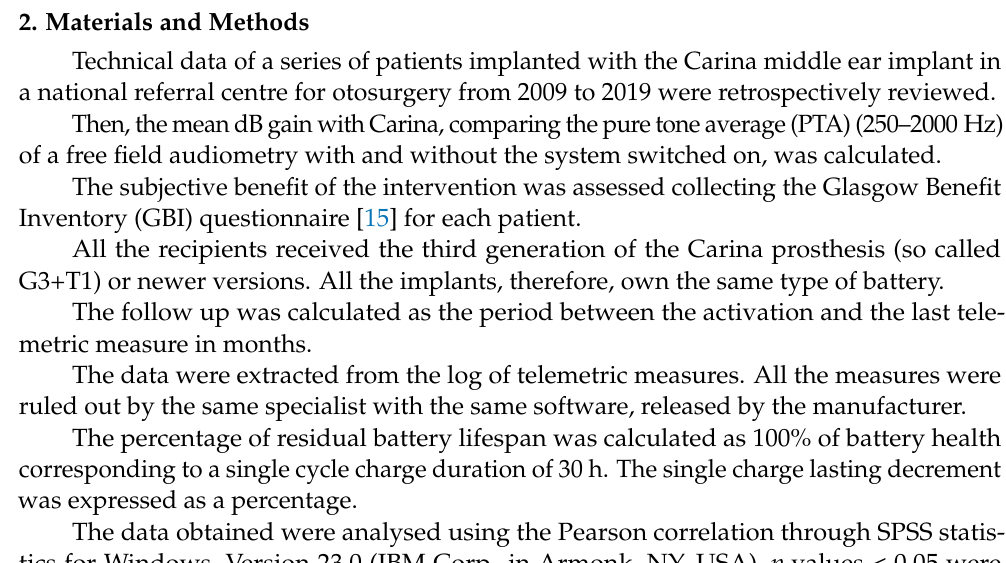
Figure 1. A scheme showing the Carina’s projected battery lifespan through the years. Figure reported and modified from the Memo Battery Testing Summary, LIB-00385—Cochlear whitepaper. The blue line is the house-made Carina projection, while the red line is our